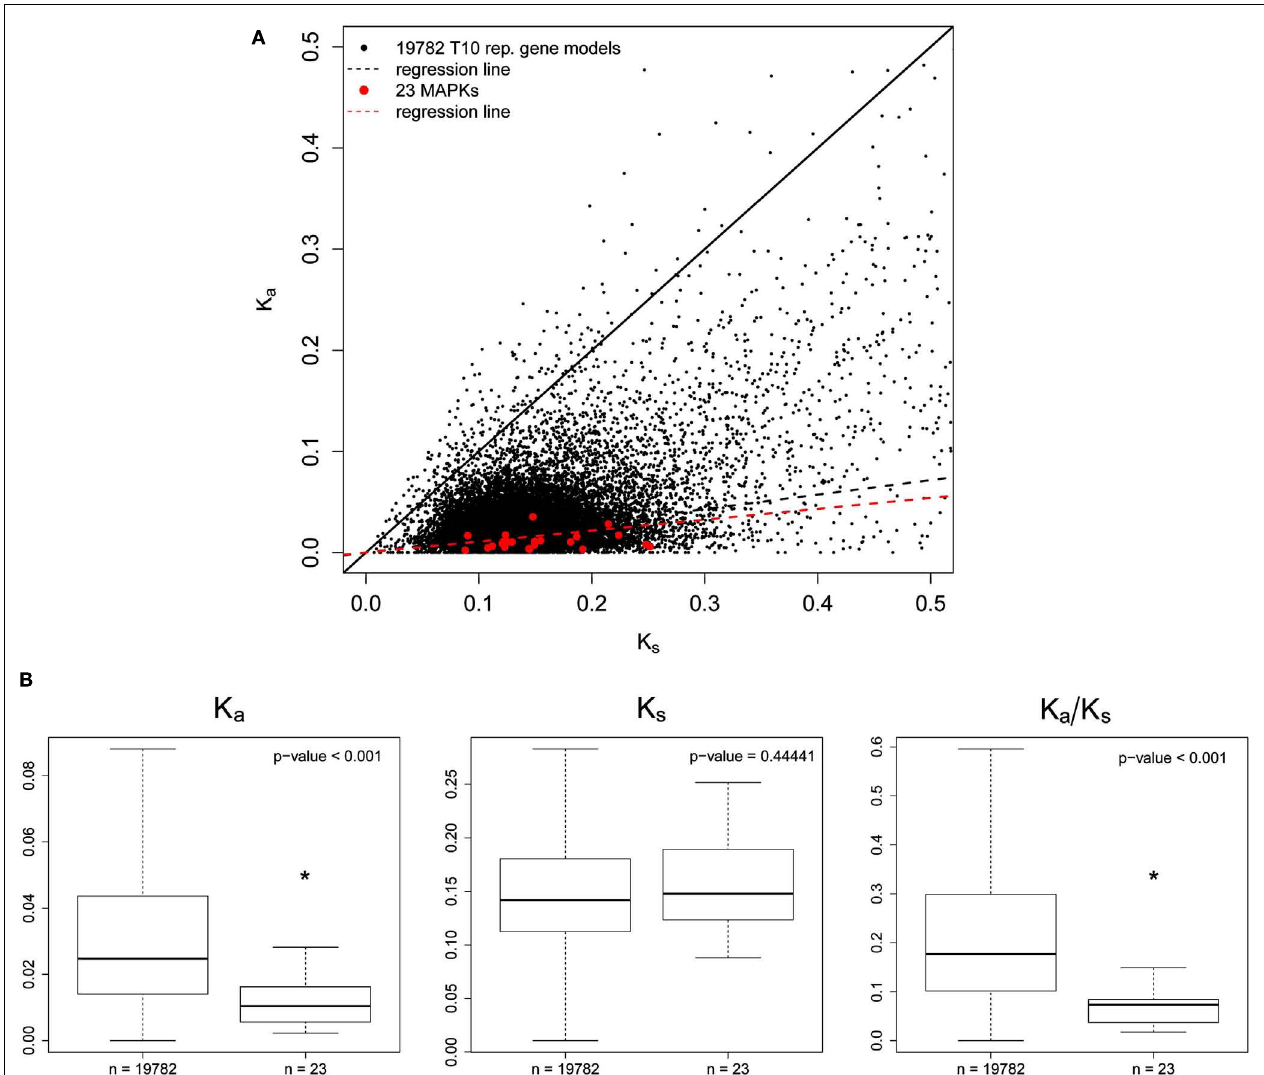
( K a = K s ); the dashed black line represents the regression line for the background data set; the dashed red line represents the regression line for the MAPKs/MAPK-likes . (B) Box plot for K a , K s , and K a / K s values of the 20 canonical MAPKs and the three MAPK-likes in comparison to the background data set. Medians are marked by solid black lines, boxes contain all data points in the 25–75% quartile range and whiskers denote 1.5x interquartile distances. Asterisks indicate significant differences (Wilcox